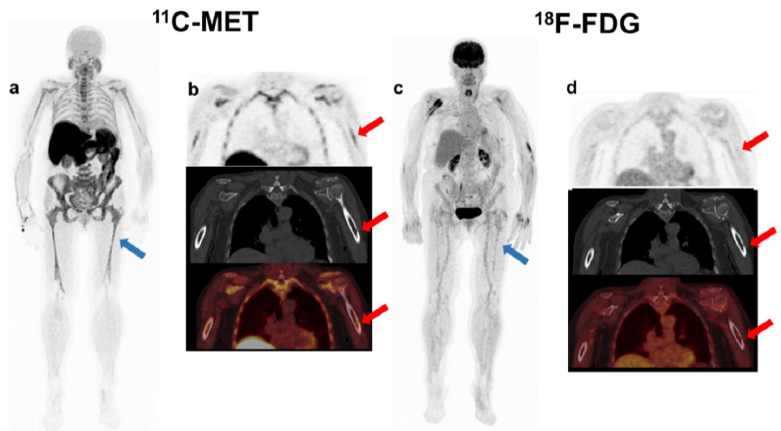
Figure 1. Patient with oligo-secretor Kappa MM, ISS 2. MET PET/CT showed diffuse BM uptake (blue arrow-( a )) and a FL with slight accumulation of the tracer in the cortical of the left humerus corresponding with a sub-centimetric lytic lesion (red arrow-( b )). Otherwise, FDG PET/CT demonstrated no focal accumulation in the FL (red arrow-( d )) and there was faint homogeneous diffuse uptake in the axial and appendicular skeleton (blue arrow-( c )), the intensity of which was lower than liver uptake (Deauville 3). The patient did not progress.